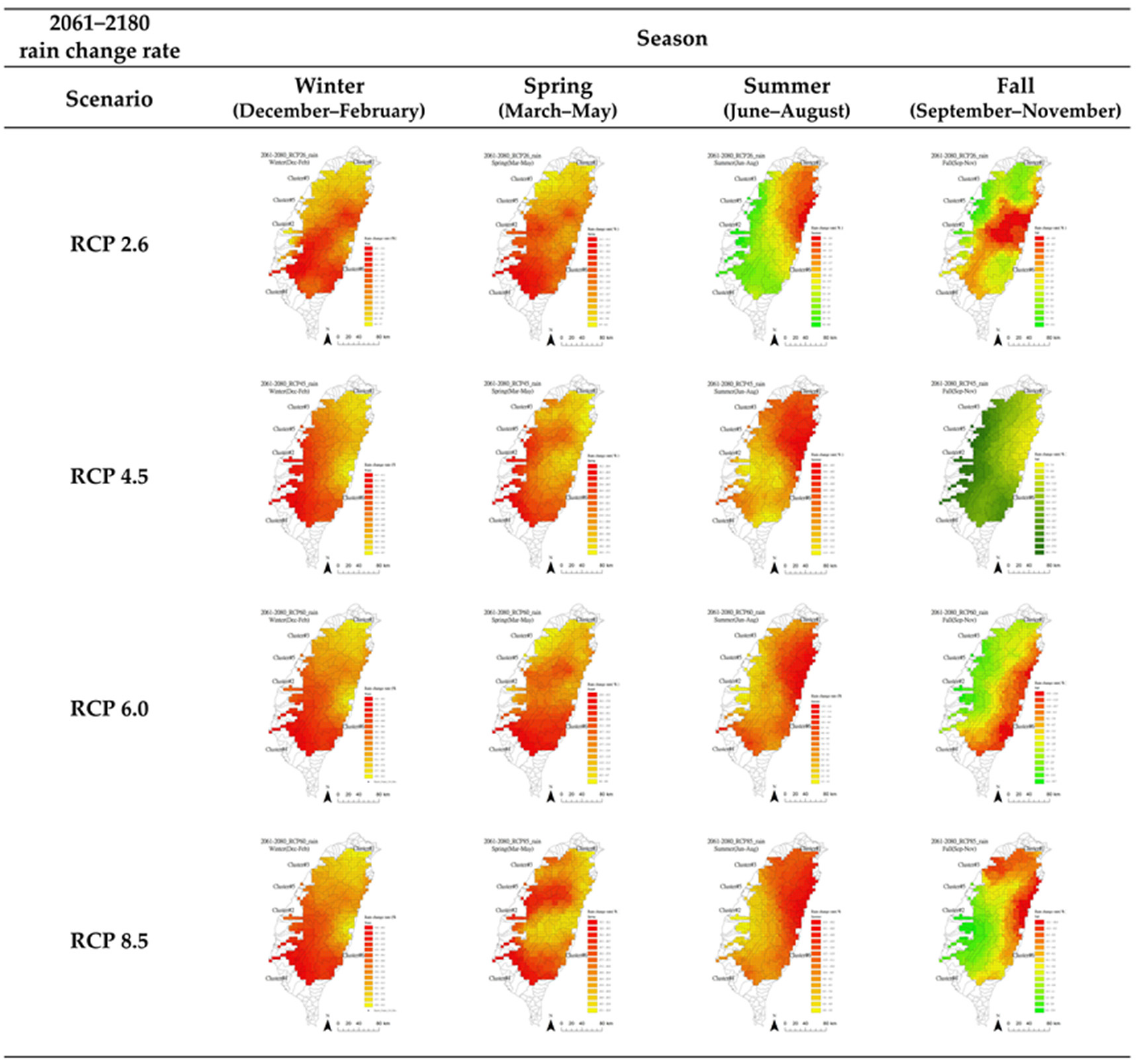
Figure A7. Spatial distribution of rain change rate from 2061–2080 for four seasons under different climate change scenar- ios.